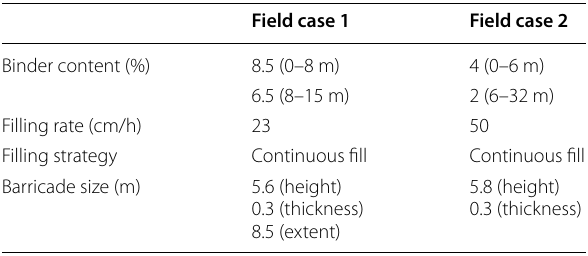
Table 2 Information of the backfill conditions for field case